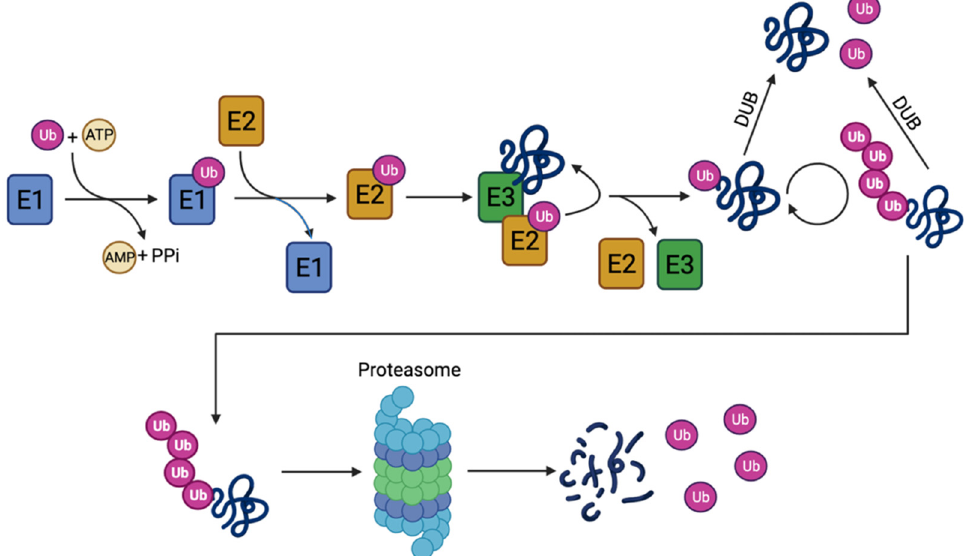
Figure 2. Visualization of the ubiquitin–proteasome system. The E1 ubiquitin-activating enzyme is loaded with ubiquitin through the cleavage of ATP into AMP and PPi. The ubiquitin is then transferred onto the E2 ubiquitin-conjugating enzyme, which can then bind to the E3 ubiquitin ligase. The E3 ubiquitin ligase recognizes the substrate and facilitates the transfer of ubiquitin from the E2 onto the target. This process can be repeated, resulting in the formation of ubiquitin chains. This can be reversed by the action of deubiquitinases (DUBs), or the ubiquitination can lead to the degradation of the target by the proteasome and the release of free ubiquitin monomers. Created using www.BioRender.com (accessed on 10 December 2022).